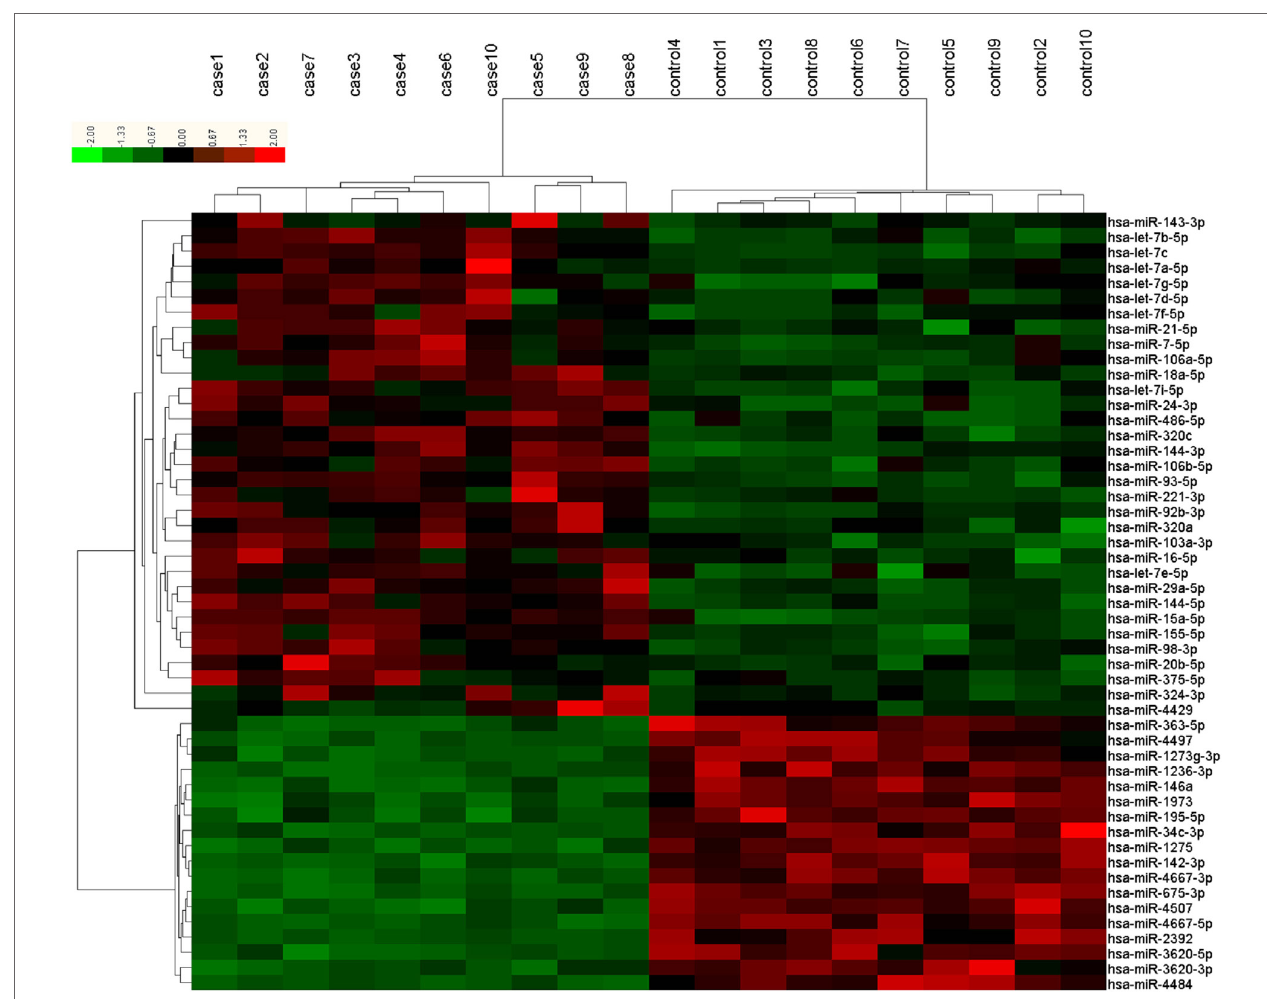
FigUre 1 | Differentially expressed plasma microRNAs (miRNAs) between type 2 diabetes mellitus (T2DM) patients ( n = 10) and healthy controls ( n = 10) in microarray. Each row represents one miRNA, and each column represents a plasma sample. The legend on the right indicates the miRNA represented in the corresponding row. The relative miRNA expression is depicted according to the color scale. Red indicates upregulation; green indicates downregulation. The numbers with case indicate newly diagnosed T2DM patients; numbers with control indicate healthy controls.